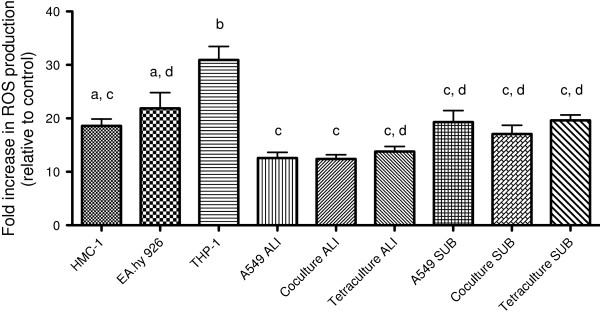
DCFH-DA assay to analyse the behaviour of the different cultures in response to oxidative stress. Cultures were preloaded with DCFH-DA dye for 45 min and subsequently exposed to 20 mM AAPH in medium for 2 h. The oxidation of DCFH-DA was measured as an augmentation of green fluorescence. The increase in ROS production was compared to cells that were treated with medium without AAPH. Data represents the mean of at least four independent transwell inserts ± SEM. Groups that are sharing the same letters are not significantly different (P > 0.05).